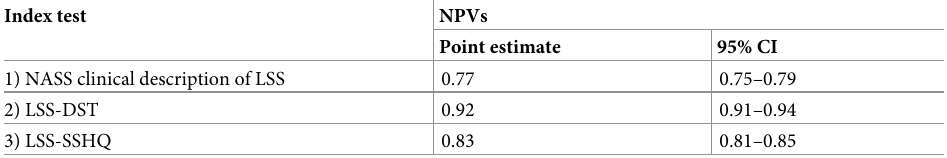
Table 5. NPVs for the NASS clinical description of LSS, LSS-DST, and LSS-SSHQ.